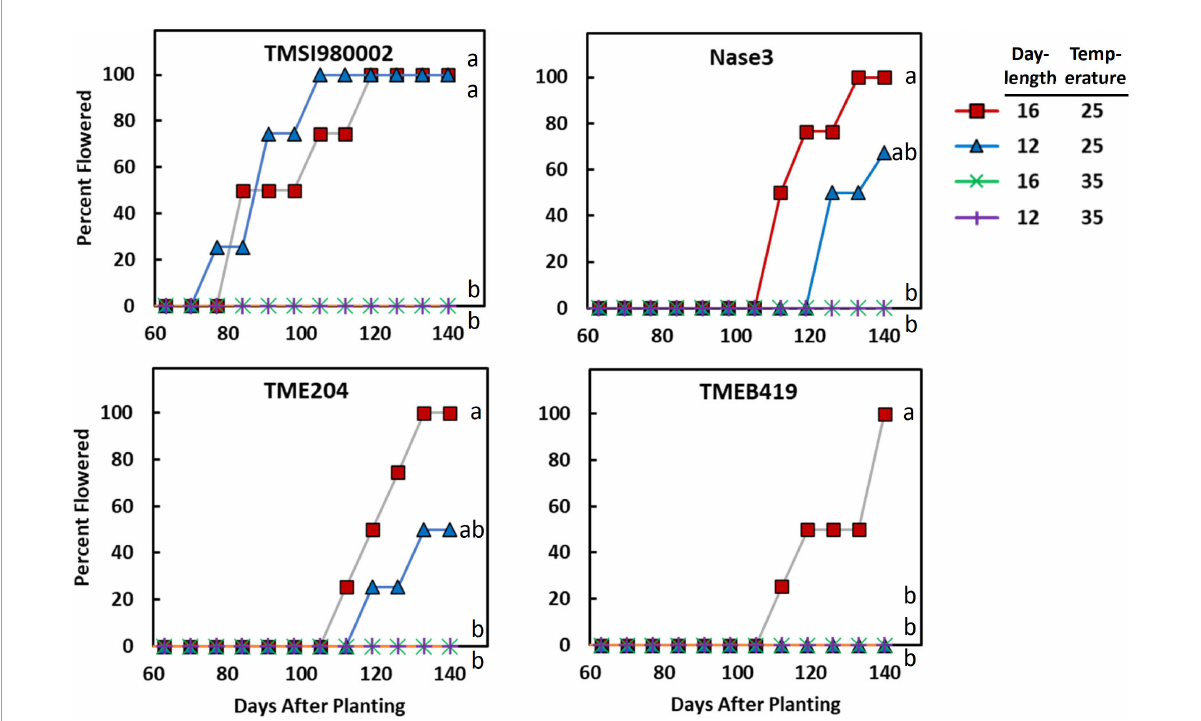
FIGURE1 The effect of photoperiod and temperature on percentage of plants flowering as a function of time in the genotypes TMSI980002, Nase 3, TME 204, and TMEB 419. Day-lengths were 16 h (12 h full light + 4 h dim light) and 12 h full light. Temperatures were 25/20 ◦ C (day/night) and 35/30 ◦ C. Data shown represent the average of 4 replicate plants for each photoperiod × temperature × genotype combination. Curves labeled with different letters differed ( P ≤ 0.05) according to Cox Proportional Hazard tests, which considers both the proportion of plants that flower and the